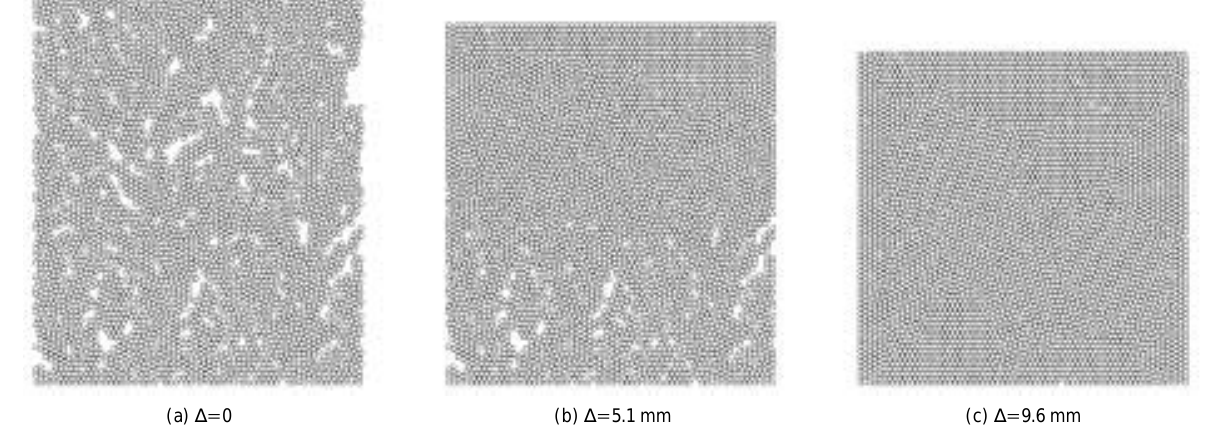
Fig. 1 Rearrangement processes of monosized particle bed. (a) Initial open structure; (b) intermediate structure; (c) closely packed